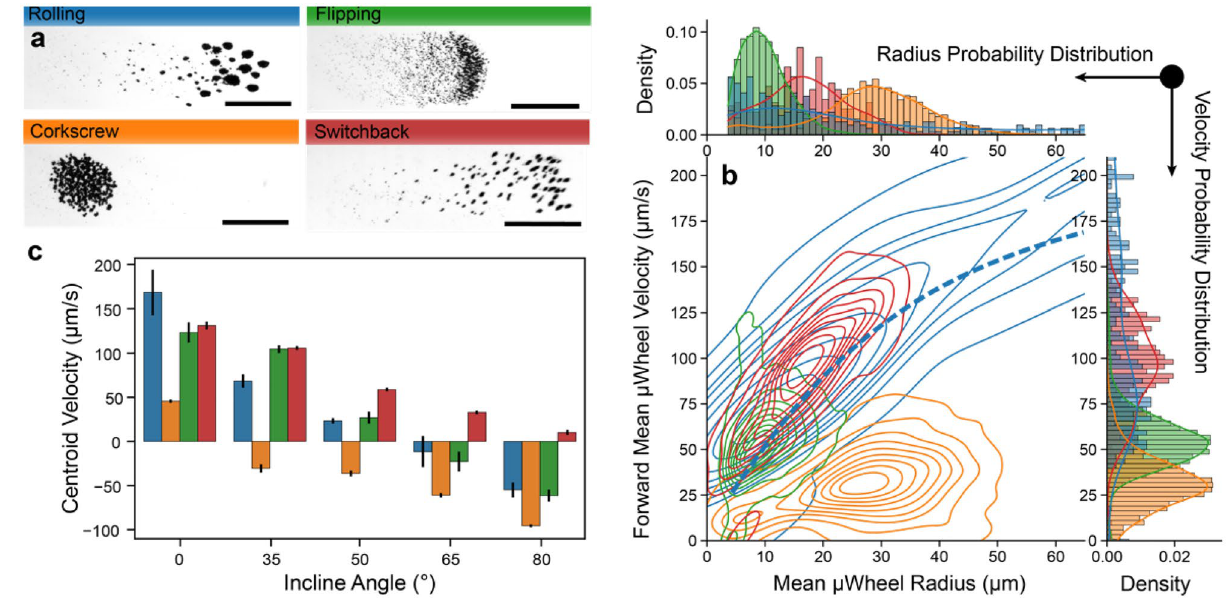
Figure 3. µWheel swarm characterization. ( a ) Optical microscopy of four swarm modes after ~ 15 s of magnetic actuation. Scale = 1 mm. ( b ) “Fingerprint” of each swarm mode. Blue dashed line is the model line at 0° from Fig. 2b. Each probability distribution is fit with a kernel density estimate to guide the eye. ( c ) Centroid, or center of mass, velocity of swarms at 0° and multiple steep angles. Error bars represent standard deviation of triplicate videos.